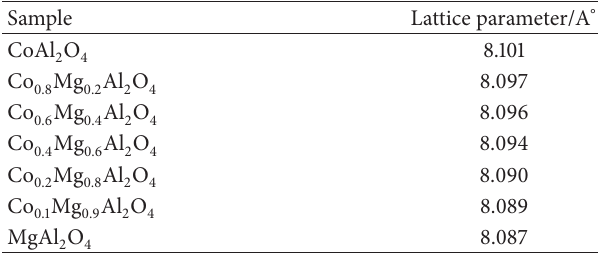
Table 2: Lattice parameter of Co 0.6, 0.8, and 1), heat treated at 800 ∘ C.